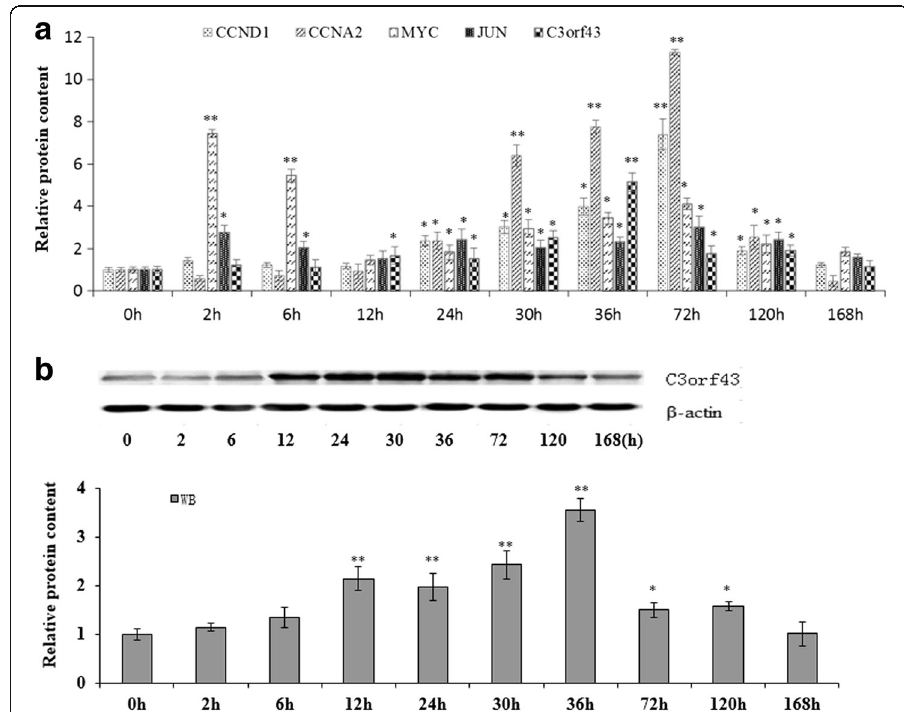
Fig. 1 The changes in content of C3orf43, JUN, MYC, CCND1 and CCNA2 in the regenerating rat liver. a The content of C3orf43, JUN, MYC, CCND1 and CCNA2 at 0, 2, 6, 12, 24, 30, 36, 72, 120 and 168 h after